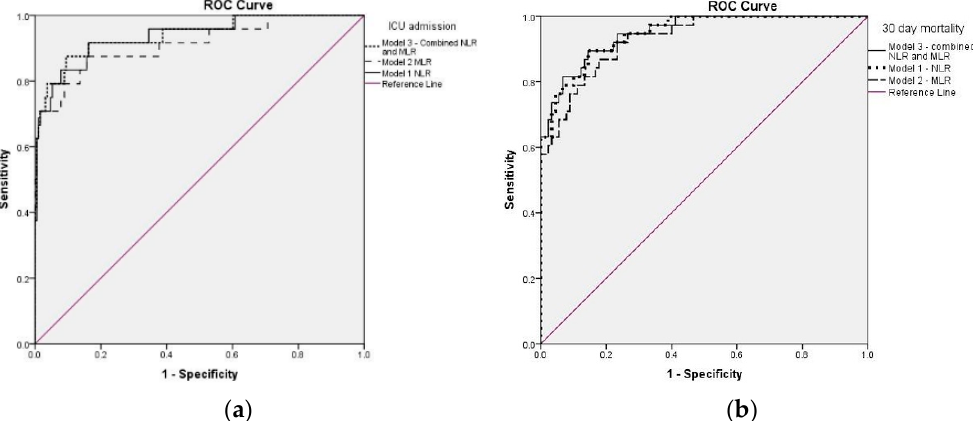
Figure 3. ROC curve for the predictive models including NLR and MLR in relation to the main outcomes: ( a ) the predictive models for ICU admission; ( b ) the predictive models for short-term mortality. Follow-up MLR was tested using a multivariate model including significant covariates Table 2. Logistic regression models for the main outcomes’ prediction including follow-up NLR. (model 2). MLR predicted 2.4-fold increased odds for ICU admission and the viral strain Delta showed more than twofold increased odds for ICU admission, while SII, presepsin and LDH showed no influence for this outcome. Notably, SaO2 upon admission (<90%) predicted fivefold increased odds for the need for ICU therapy (Table 3). The resulting ROC curve (Figure 3a) had an AUC of 0.912 (95%CI: 0.838–0.986, p < 0.001), and the PPV was 97% and the NPV was